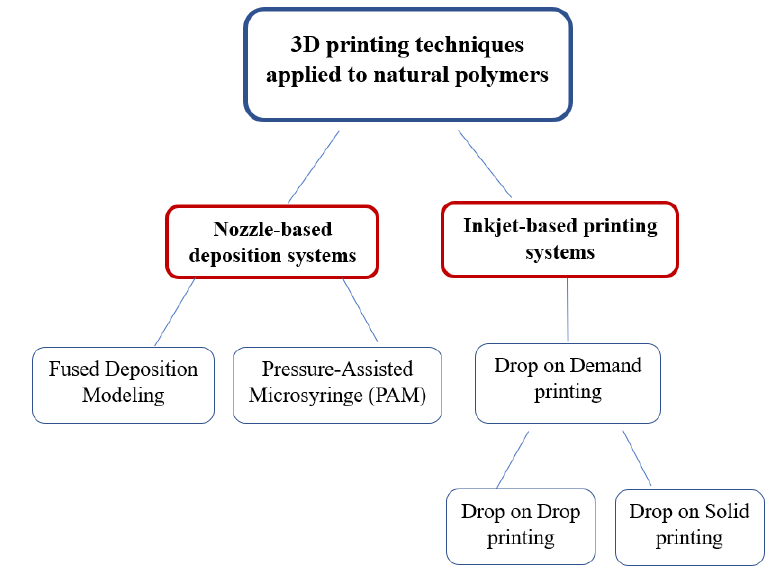
Figure 1. Classification of 3D printing technologies used for natural products.